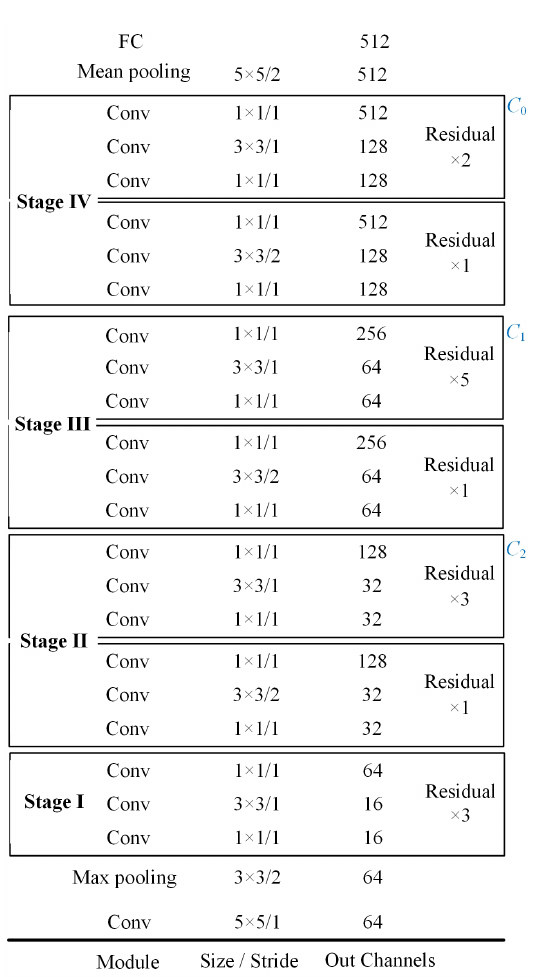
Figure 8. Feature fusion backbone network